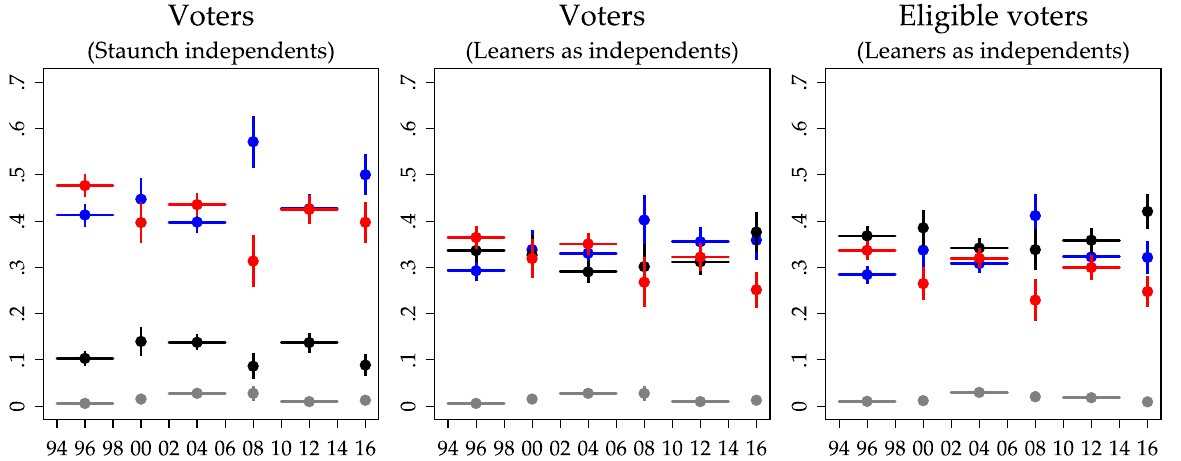
Figure 8: Class V trends in identification with the Democratic Party (blue), Republican Party (red), another party (gray), and independent (black).